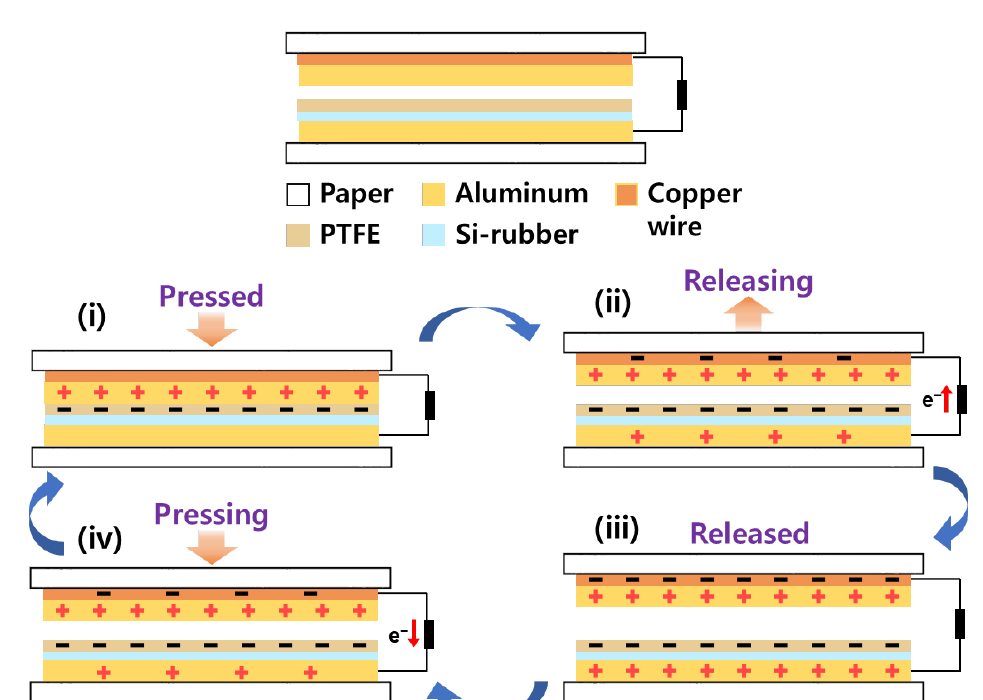
Figure 2. Working mechanism of FP-TENG in the vertical contact – separation mode. ( i ) When an external force is applied to the top of the FP-TENG, aluminum and PTFE/Si rubber come into contact with each other. ( ii ) When the two materials are separated, a potential difference occurs and electrons flow from the bottom to the top. ( iii ) When no external force is applied, the equilibrium state is maintained and the flow of electrons stops. ( iv ) When an external force is applied again, the potential difference decreases and electrons flow in the reverse direction.